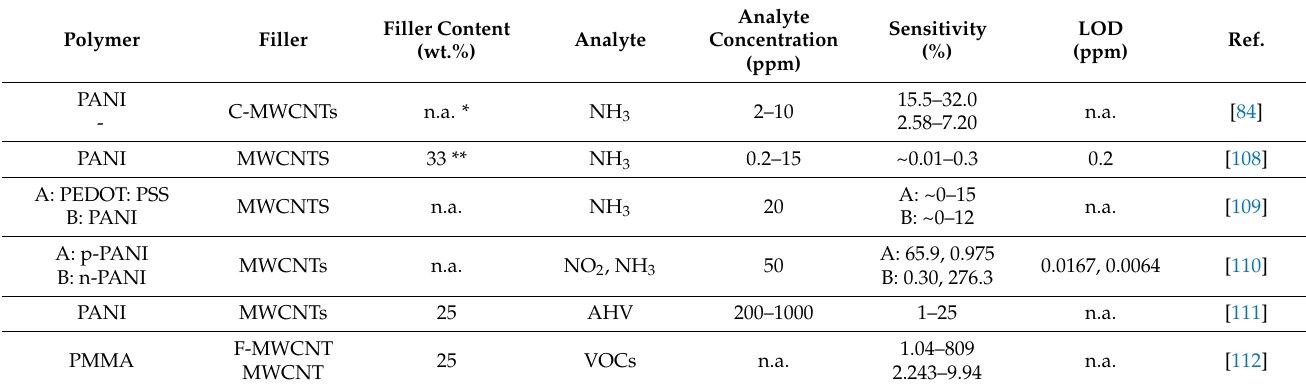
Table 5. CNTs/polymer nanocomposite films as chemiresistive